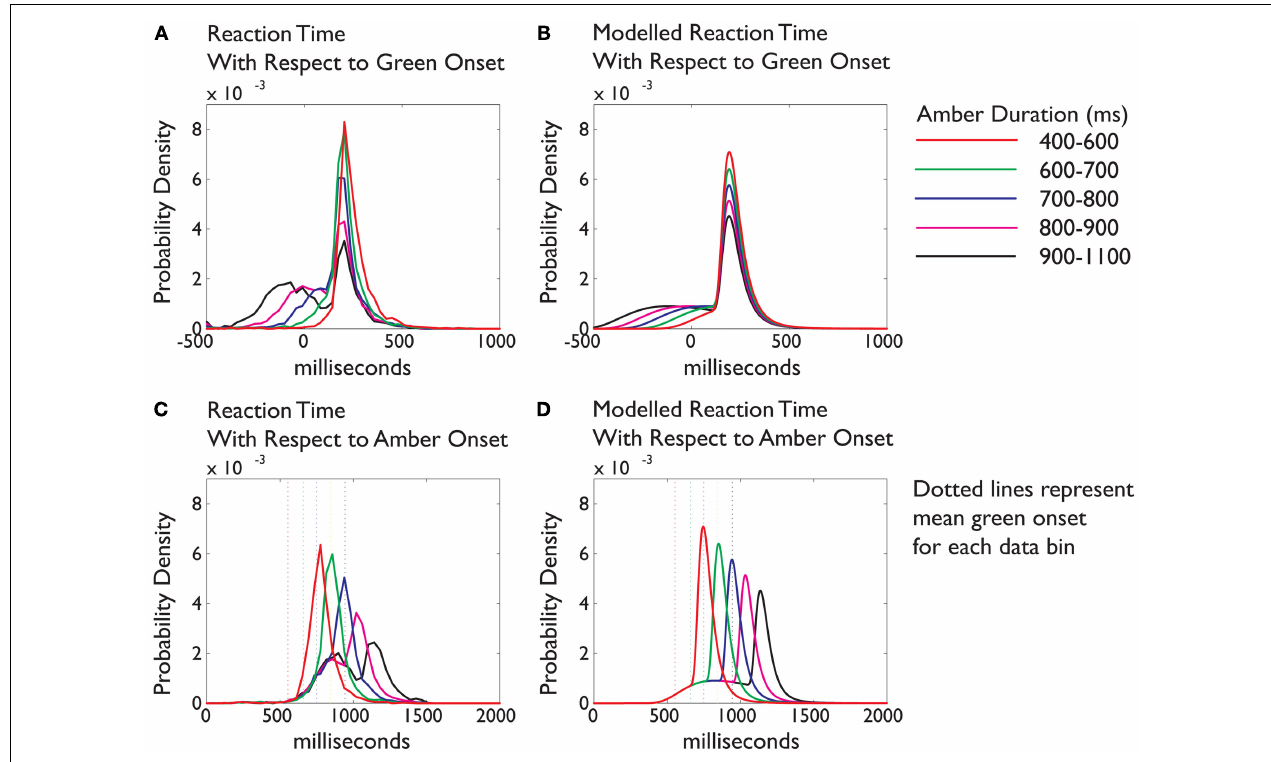
anticipations increases as amber duration increases. Importantly, our model (top and bottom right) reproduces the observed increase in anticipatory responses with increasing durations of amber: Penalized early responses tend to be elicited on trials for which amber duration is longer than